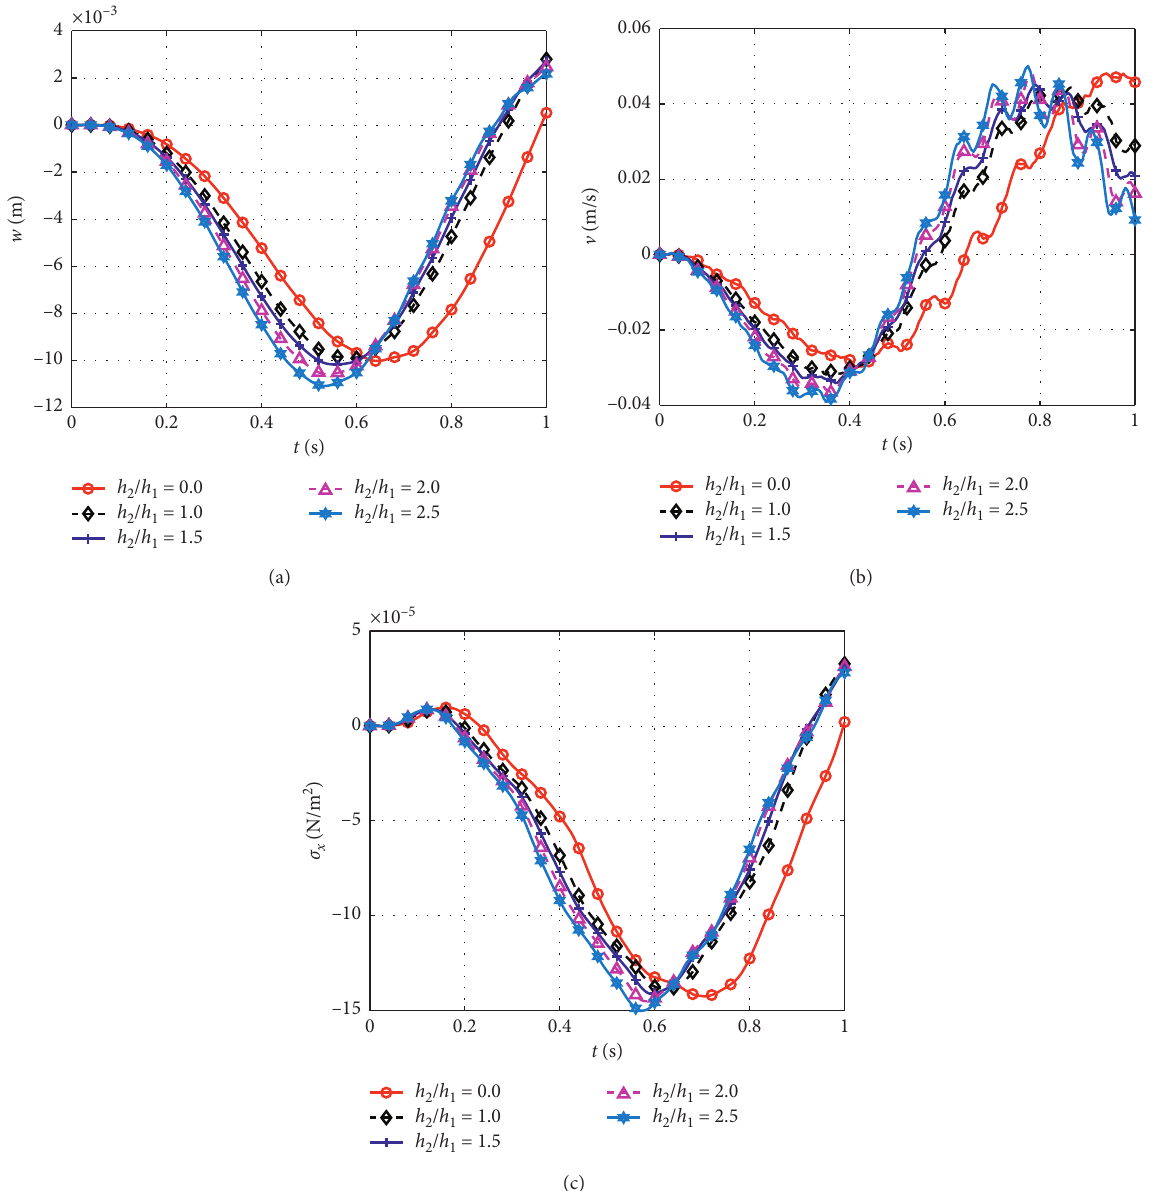
w versus time, (b) velocity 2 / h 1 ratios. (a) Deflection